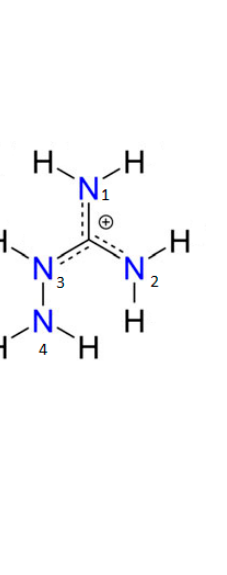
Figure 1. Forms of aminoguanidine (AG) considered in this study (on the left, protonated AG, AGH + ; on the right, the four conformers of AG in stability order).